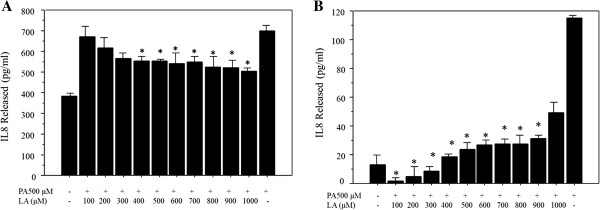
Assessment of IL8 production due to free fatty acid treatment by commercial ELISA kit. A. IL8 production in Huh-7 cells. The IL8 production was significantly reduced by the co-incubation with linoleate compared to the cells treated by palmitate alone; with 400-1000 μM linoleate in the Huh7 cells. The data represent a mean value of 4 experiments ± standard deviation. *p = 0.041 compared with cells treated by palmitate alone. B. IL8 production in HepG2 cells. The IL8 production was significantly reduced by the co-incubation with linoleate compared to the cells treated by palmitate alone; with 100-900 μM linoleate in the HepG2 cells. The data represent a mean value of 4 experiments ± standard deviation.*p = 0.011 compared with cells treated by palmitate alone.